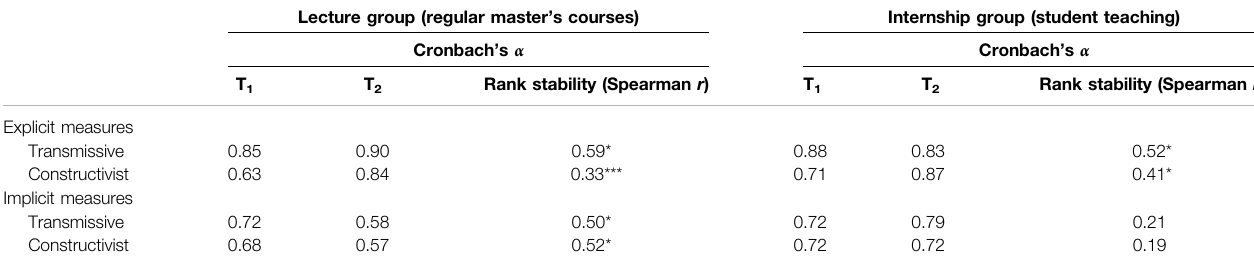
TABLE 1 | Reliability of implicit and explicit measures at T 1 (beginning of semester) and T 2 (end of semester).